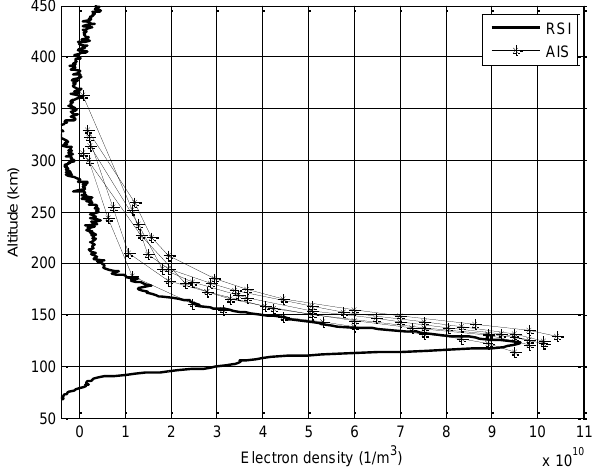
Fig. 3. First Comparison between a profile obtained from Mars Ex- press Radio Science (Year: 2004, DOY: 180, Latitude: 10.2471 ◦ , SZA=74.6059 ◦ , Ls=53.21 ◦ , F 10 . 7 =85) (bold line) and some top- side profiles obtained from MARSIS instrument with similar con- ditions of location, solar zenith angle, solar activity and solar longi- tude (Orbit: 3065, ionograms: 20–40, SZA=61-65 ◦ , Latitude=11– 1 ◦ , Ls=59.65 ◦ , F 10 . 7 =80) (light lines).